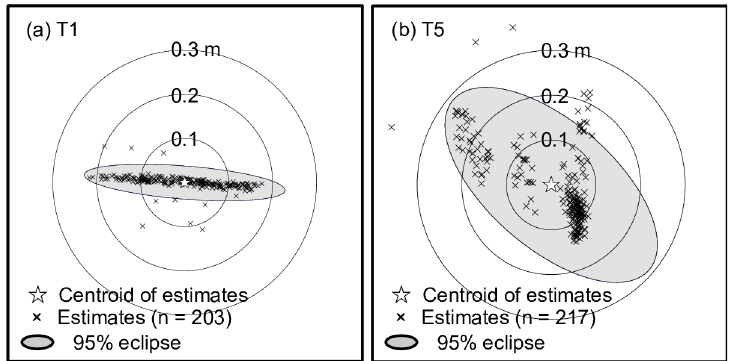
Fig 5. Stationary test results. (a) 2D estimates with their centroid, and 95% eclipse for the deployment of T1 near a centroid of triangulation, and (b) T5 outside